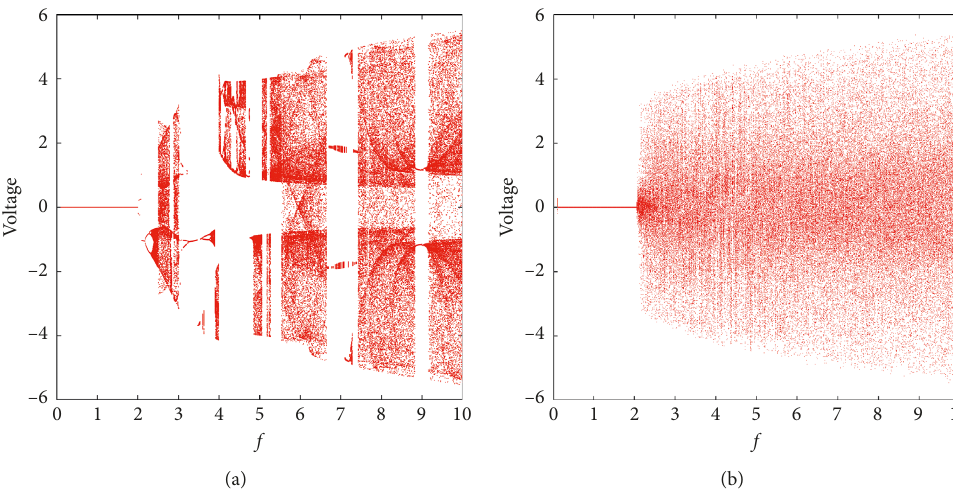
Figure 10: Bifurcation diagram of the output voltage with the variation in f : (a) c � 0 . 0; (b) c � 0 . 1.